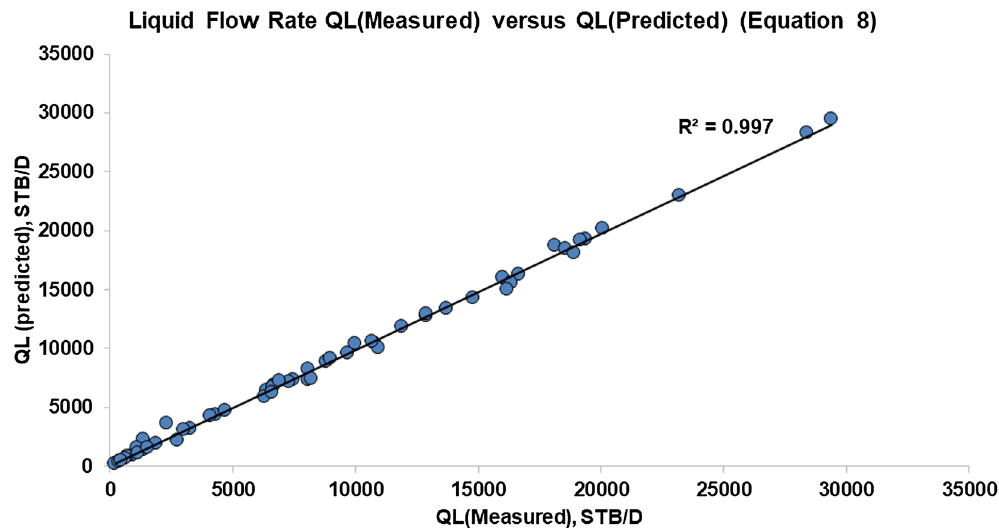
Fig. 6 Liquid flow rate Q Q L(predicted) versus L(measured) reveals a strong correlation and high reliability and accuracy for the Reshadat oil field applying the GA optimized Eq. (8) to the test data subset (55 data records)